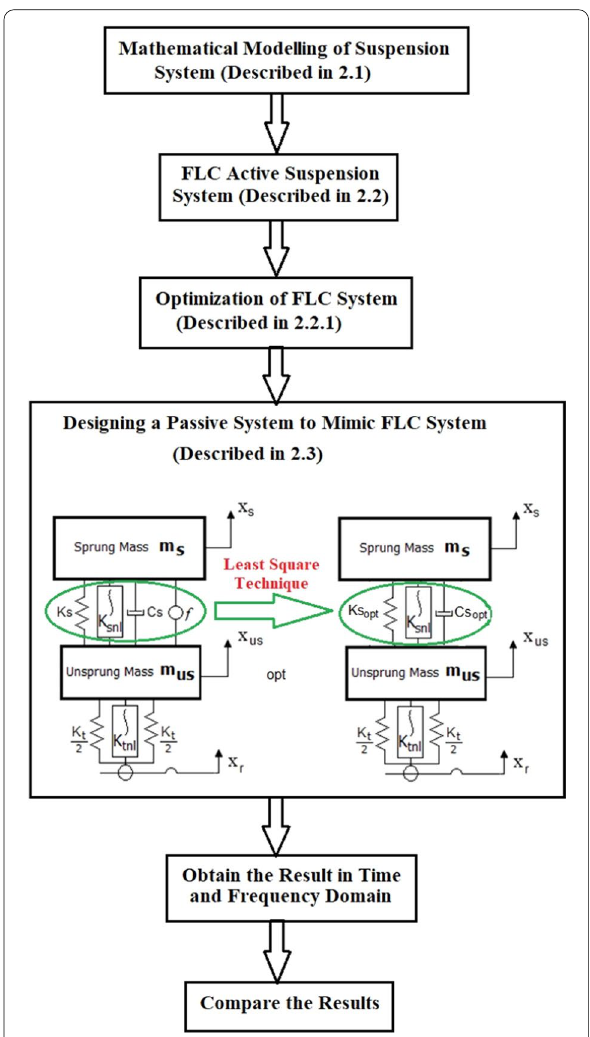
Fig. 5 Flowchart—passive suspension mimicking FLC